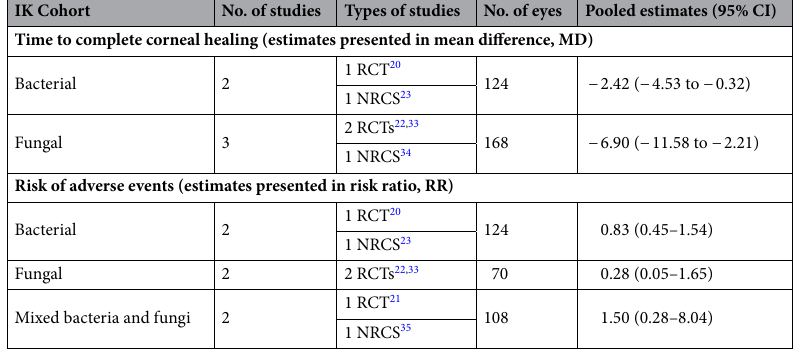
Table 4. Pooled estimates of the time to complete corneal healing and risk of adverse events between adjuvant amniotic membrane transplantation (AMT) and standard antimicrobial treatment (SAT) alone based on comparative studies, including randomized controlled trials (RCTs) and non-randomized controlled studies (NRCS). A negative MD value indicates that adjuvant AMT group has a shorter time to complete corneal healing compared to SAT alone group. IK infectious keratitis, CI confidence interval.